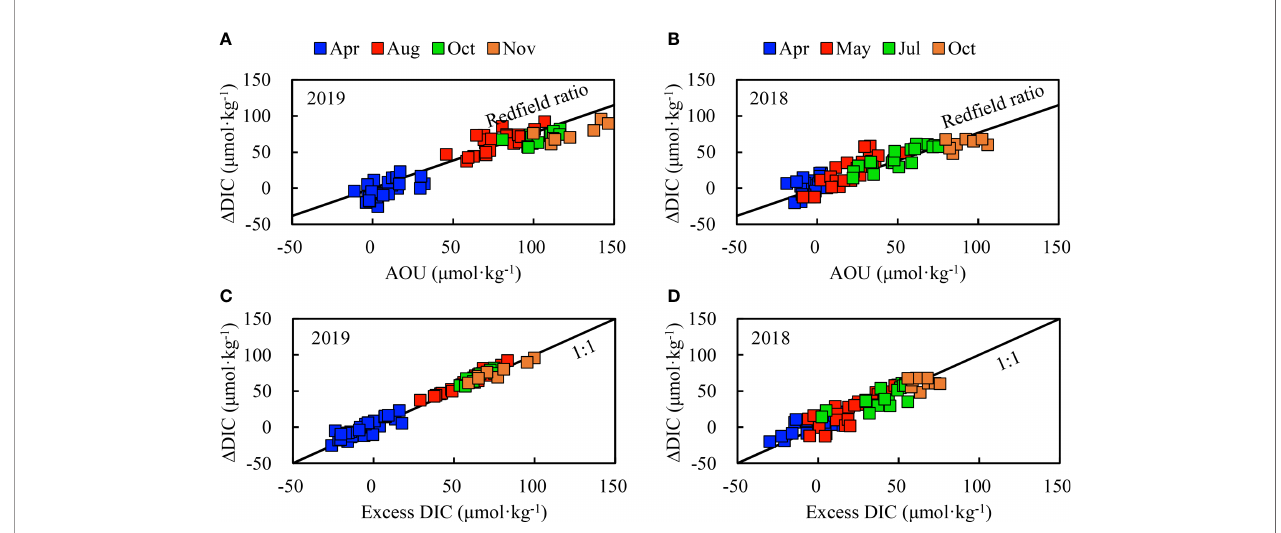
FIGURE 11 | Relationships between D DIC and AOU (A, B) and between D DIC and excess DIC (C, D) in bottom waters of the SYSCWM. D DIC = non-conservative addition (positive values) and/or removal (negative values) (see Equation